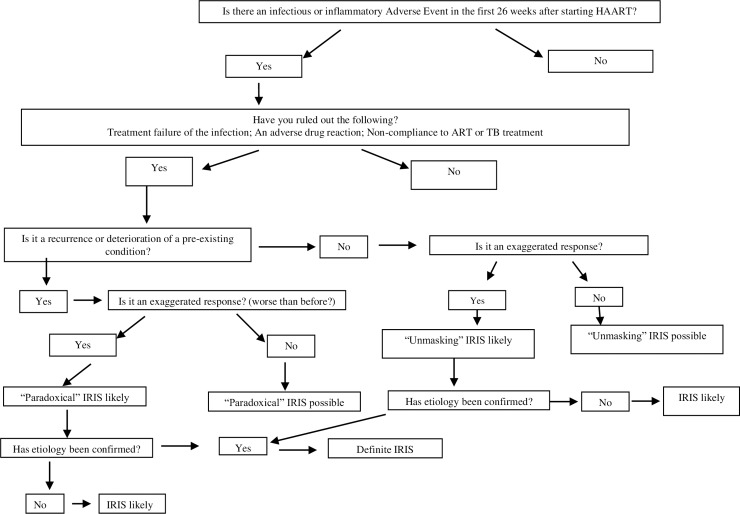
Algorithm for evaluating IRIS events.